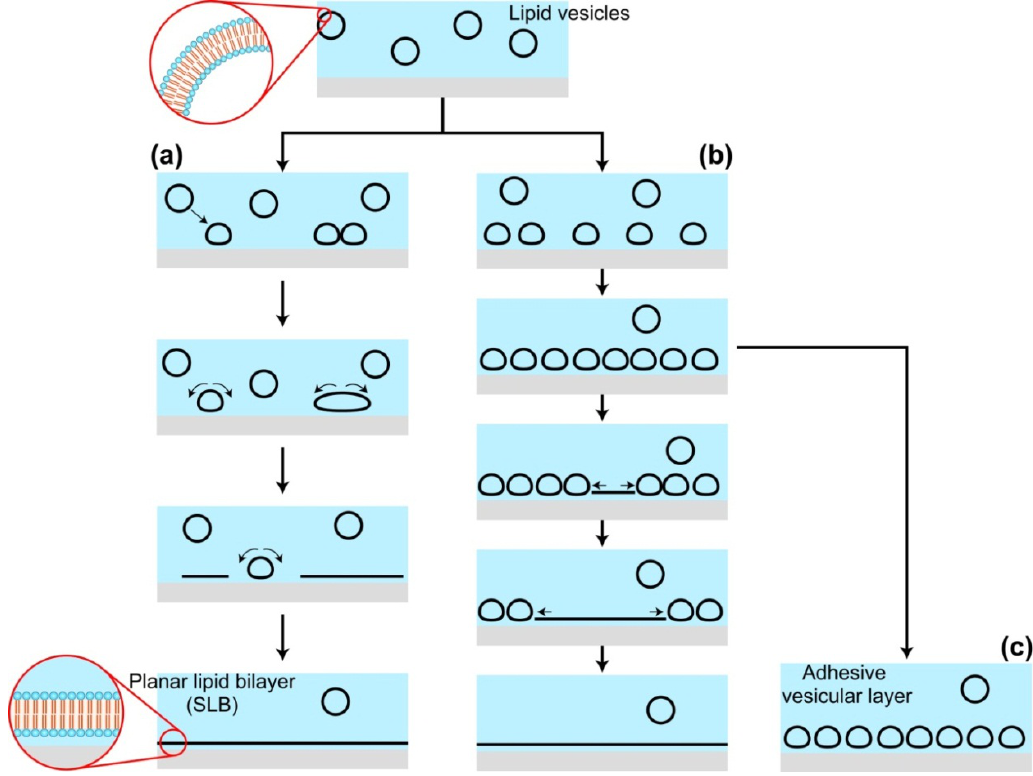
Figure 1. Schematic drawing of the shape transformation of lipid vesicles at a liquid-solid interface during the SLB formation by the vesicle fusion method. ( a ) Individual adsorbed vesicle ruptures and transforms to a SLB patch; ( b ) Vesicles adsorb until their coverage reaches to a threshold, and the rupture of a vesicle triggers the SLB growth by stimulating the neighboring vesicles; ( c ) A stable layer of adhesive vesicles, which does not transform to a planar lipid